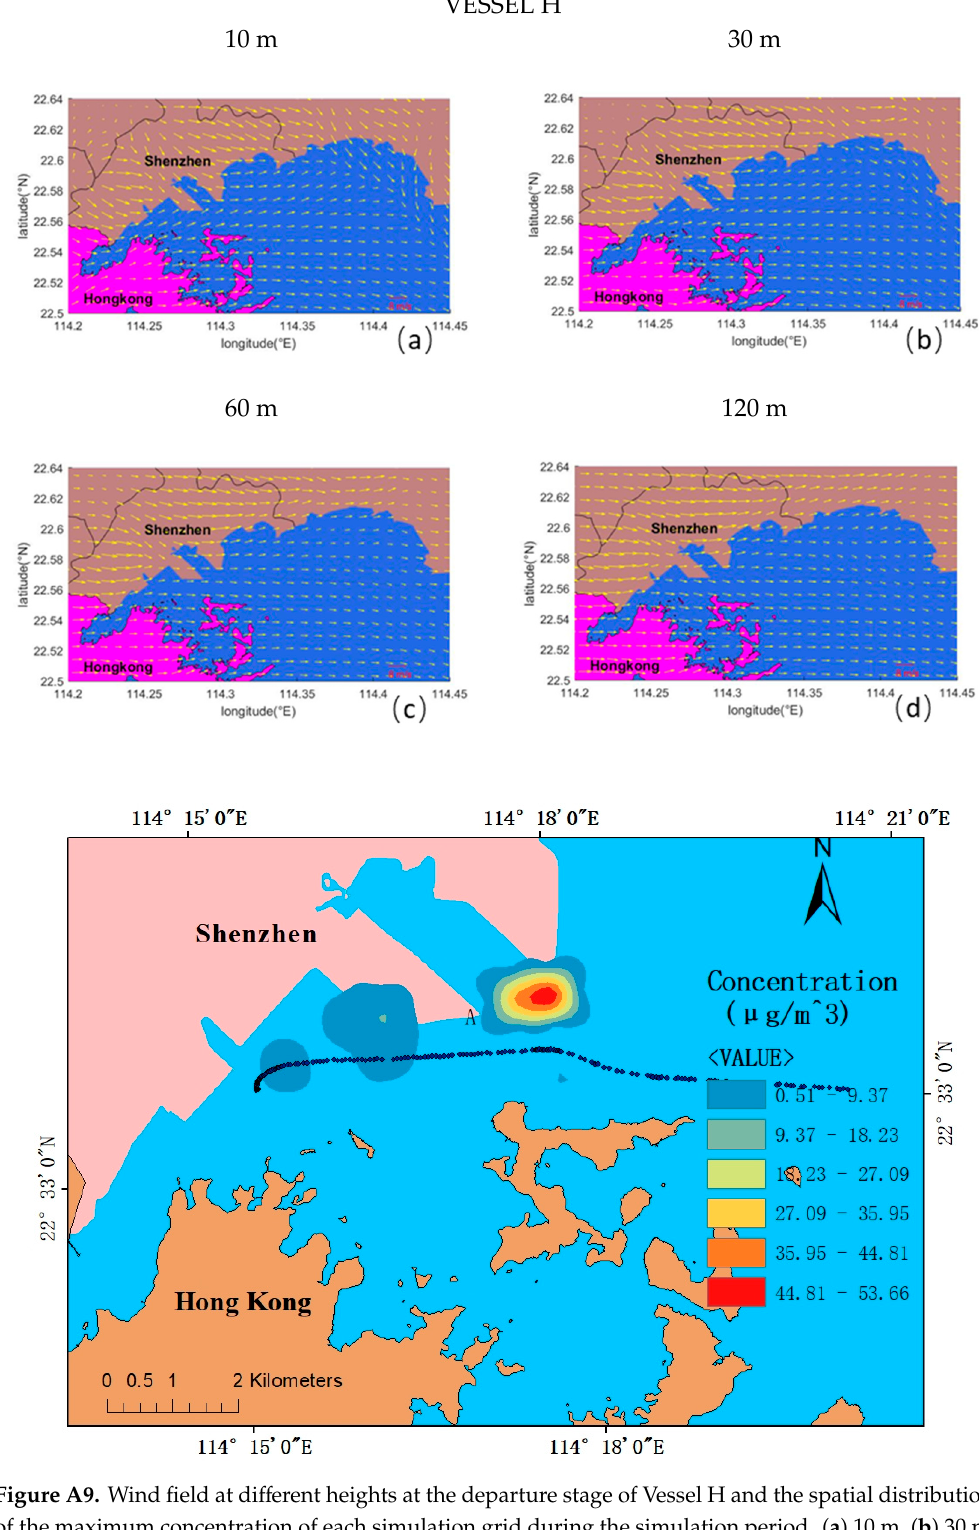
Figure A9. Wind field at different heights at the departure stage of Vessel H and the spatial distribution of the maximum concentration of each simulation grid during the simulation period. ( a ) 10m, ( b ) 30m, ( c ) 60m and ( d ) 120m.